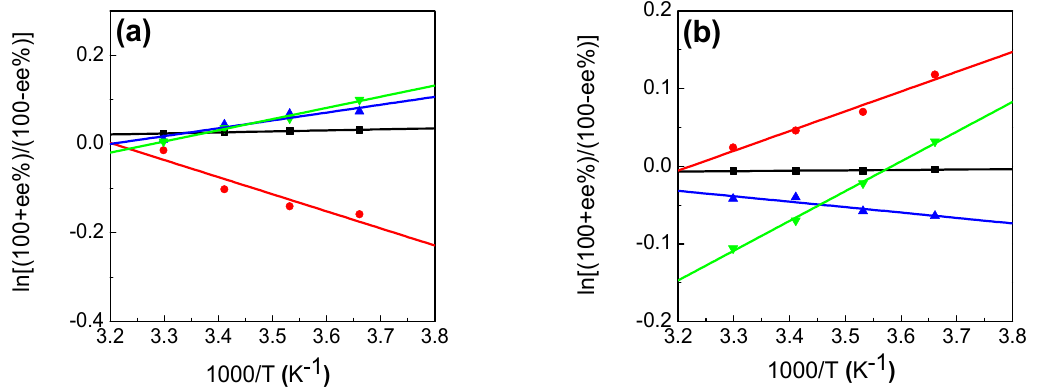
a Irradiation with a LED lamp at 365 nm for 2h or a solid state laser at 532 nm for 2 h, in borate buffer solution (pH 9.0). b Conversion ratio, relative yield and ee determined by chiral high-performance liquid chromatography (HPLC).